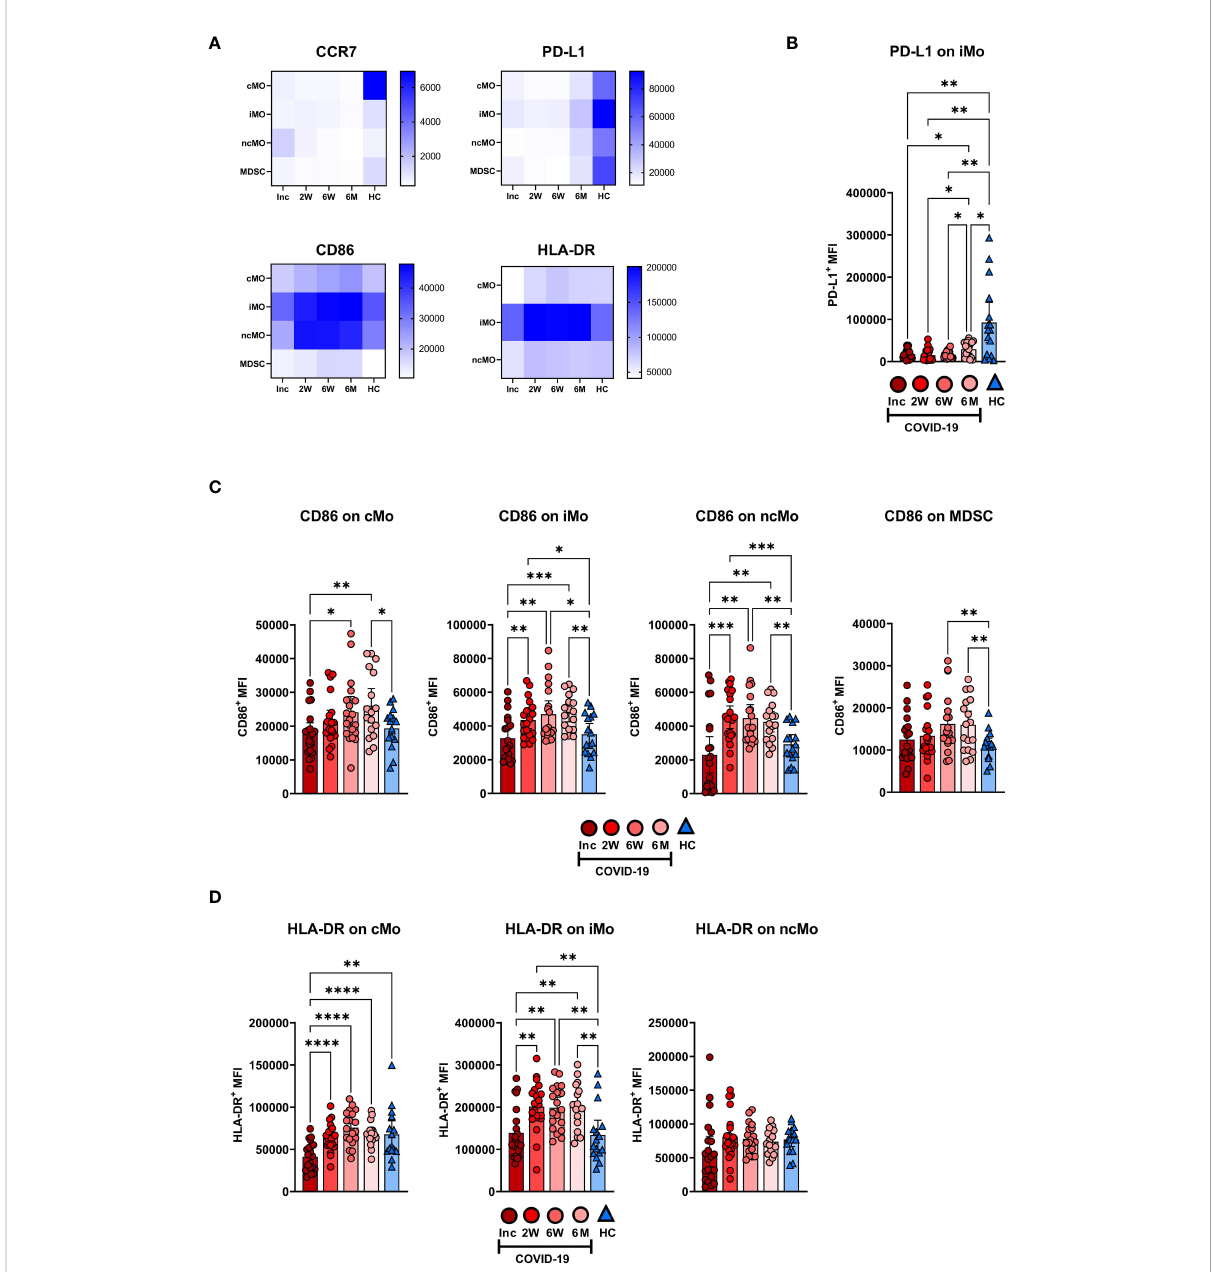
FIGURE 6 Long-term changes in the phenotype of blood monocyte subsets and myeloid derived suppressor cells in COVID-19 patients. PBMCs were collected from hospitalized COVID-19 patients (N=21) and healthy controls (N = 16) over a 6 − 7 month period. (A) Heatmaps showing the mean fl uorescence intensity (MFI) of CCR7, PD-L1, CD86, and HLA-DR on monocyte subsets and MDSC, from all donors. (B) Representative graph of PD-L1 on iMo. MFI of (C) CD86 and (D) HLA-DR on monocyte subsets and MDSC. Data is represented as mean with 95% Cl, with signi fi cance of *p ≤ 0.05, **p ≤ 0.01, ***p ≤ 0.001, ****p ≤ 0.0001., determined using Brown-Forsythe and Welch ANOVA tests. Inc, Study inclusion; 2W, 2 weeks; 6W, 6 weeks; 6M, 6-7 months; HC, healthy